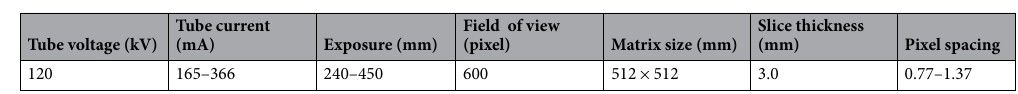
Table 2. Planning-CT image acquisition